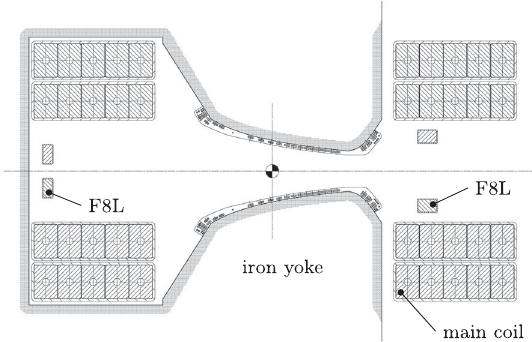
FIG. 19. Modeling of the PS MU. Even though the junction between the two half-units is included as SBEND, it is actually just a drift